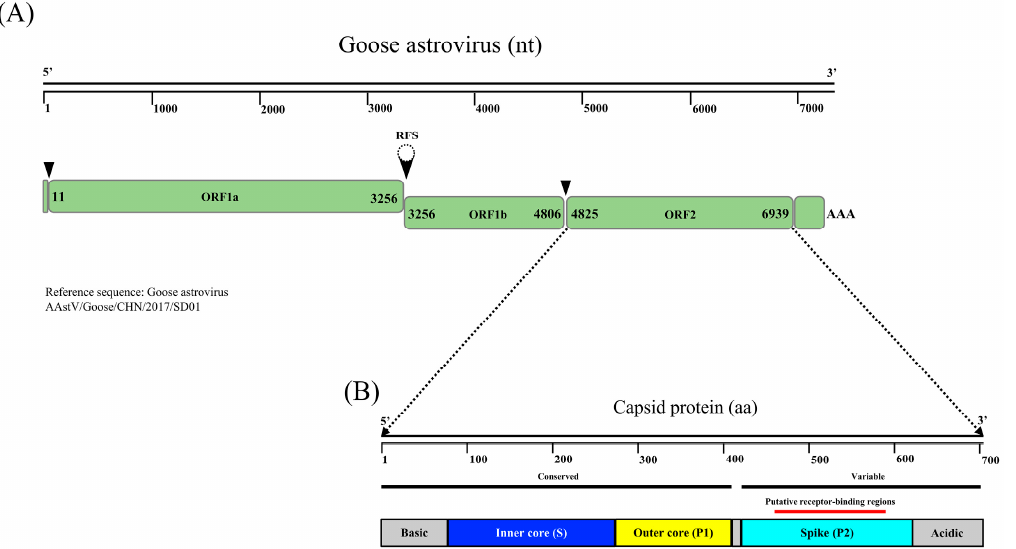
Figure 2. The genome structure of GoAstV. ( A ) The GoAstV genome contains three ORFs that encode three proteins (adapted from [24]). The sequences of ORF1a and ORF1b overlap. ( B ) Schematic of GoAstV capsid protein (CP) domain structure (adapted from [25]). The CP is colored by structural domains, with the inner core domain in blue, the outer core domain in yellow, and the spike domain in cyan.